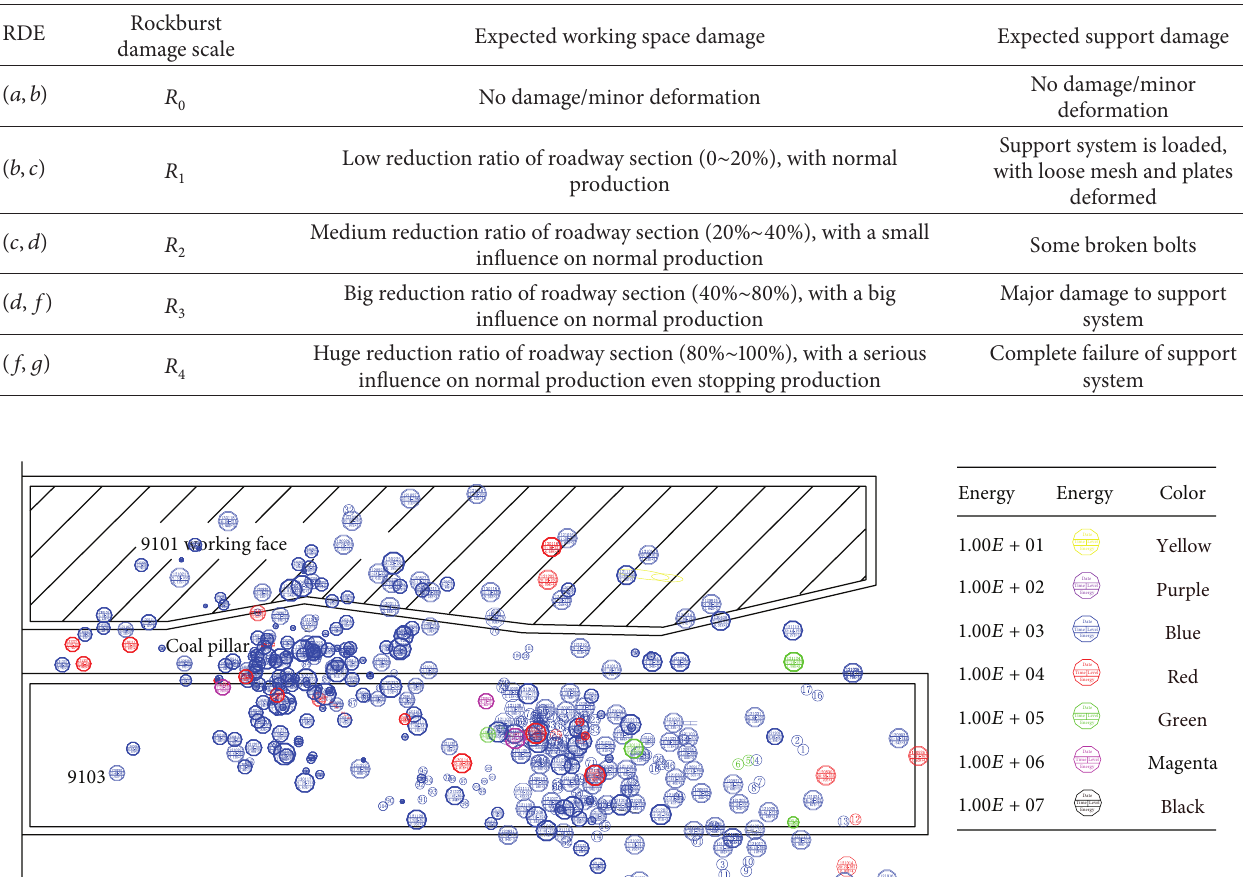
Table 3: Rockburst damage potential scale.